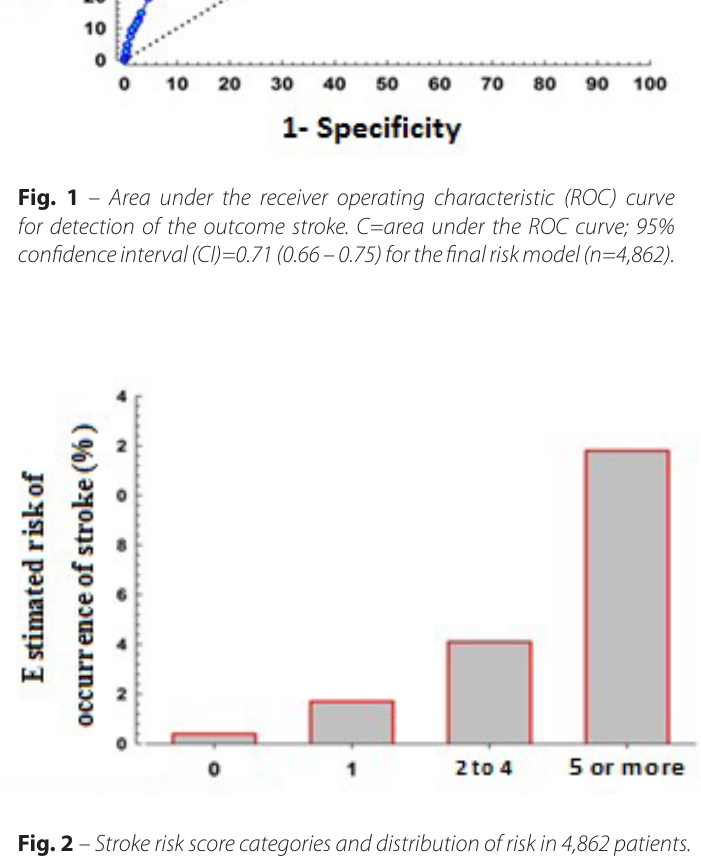
Fig. 2 – Stroke risk score categories and distribution of risk in 4,862